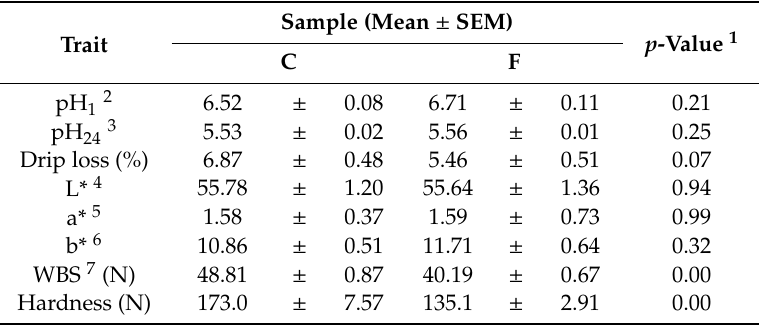
Table 4. Physical characteristics of the longissimus dorsi muscle of pigs fed either a standard diet (C) or a diet with 8% fish oil